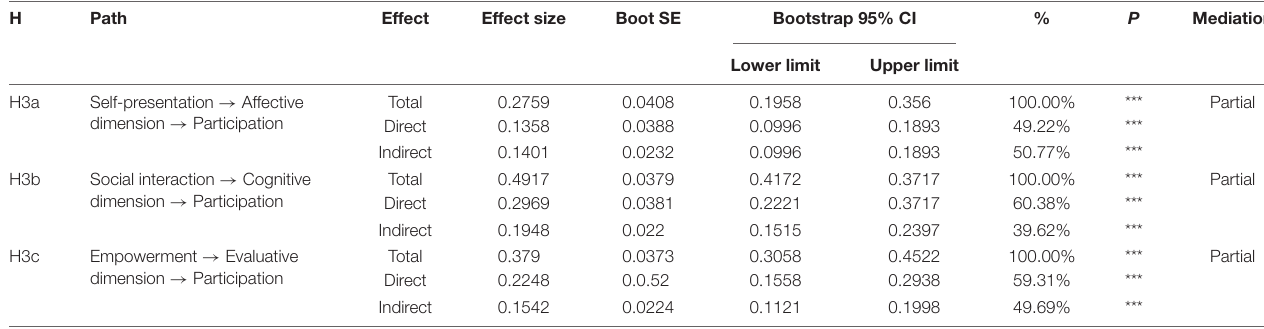
TABLE 4 | The mediating effect of